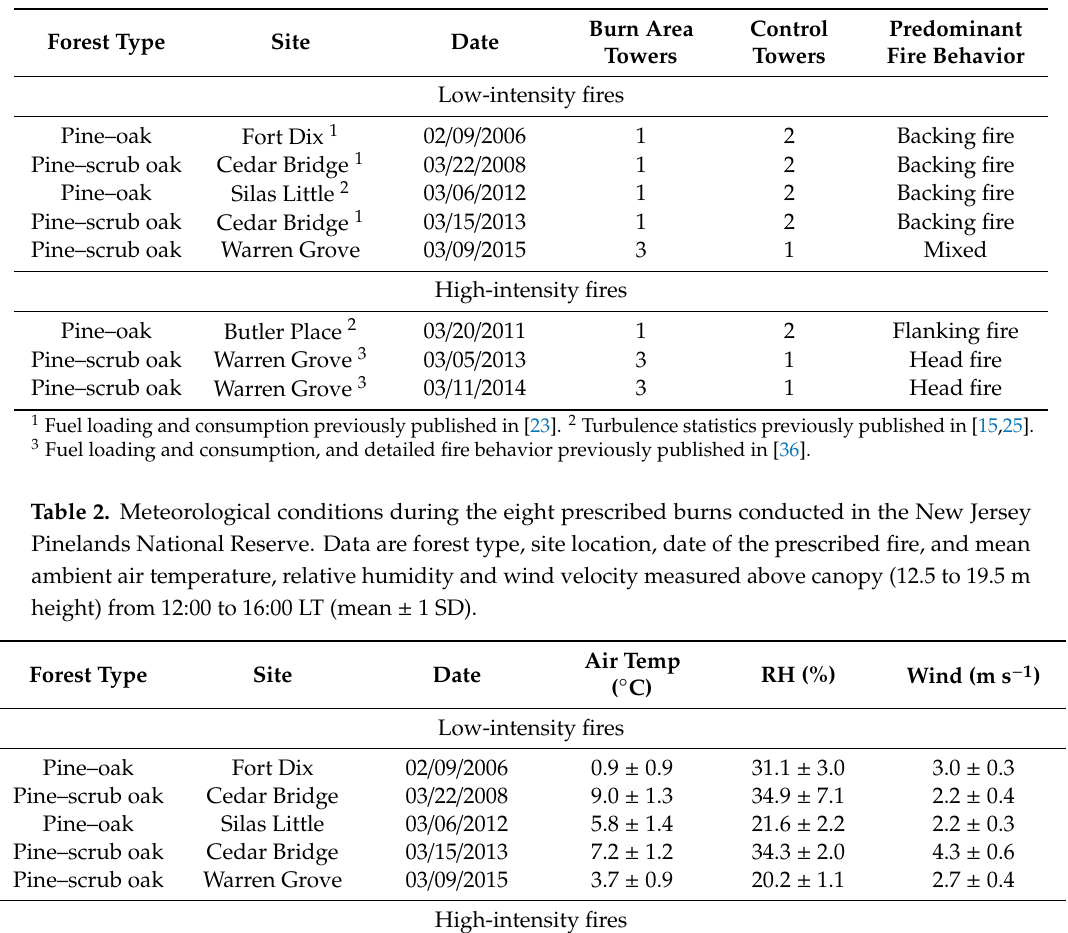
Table 1. Forest type and experimental design for the eight prescribed fires conducted in the New Jersey Pinelands National Reserve. Data are forest type, site location and date of the burn, number of towers within each burn area, number of control towers, and predominant fire behavior when flame fronts reached the tower(s).